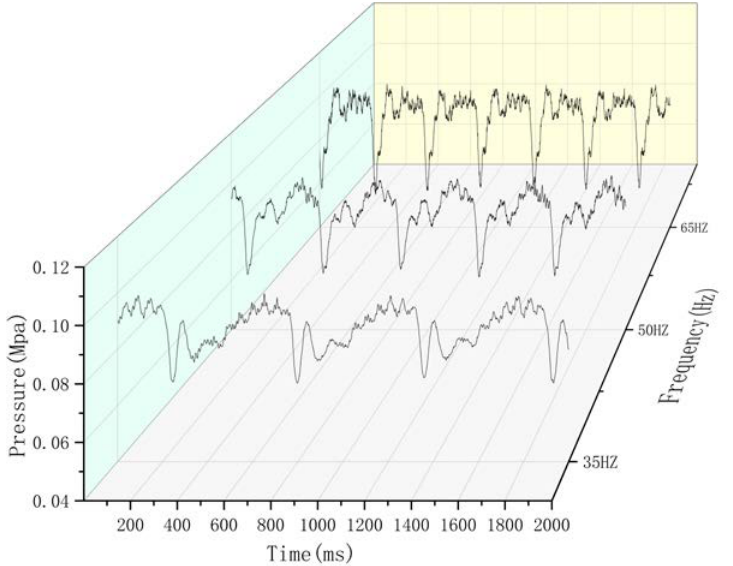
Figure 15. Pulsating pressure experimental results at different speeds with an outlet pressure of 0.1 MPa. 0.1